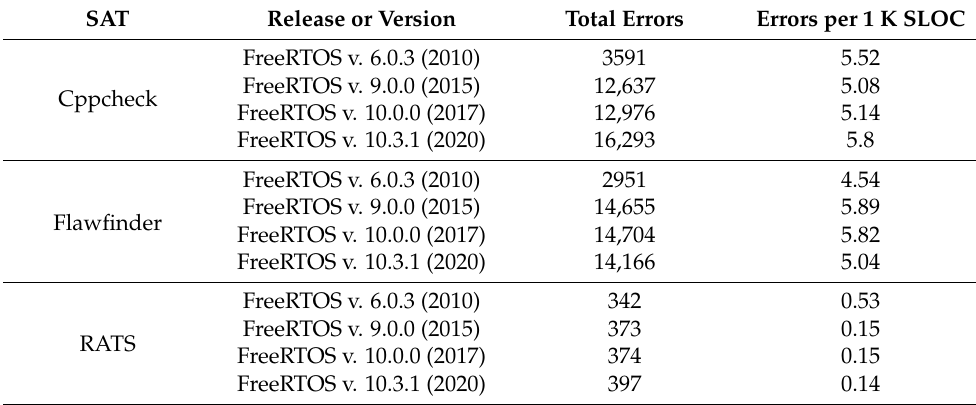
Table 6. Total errors and errors per 1K SLOC of FreeRTOS.